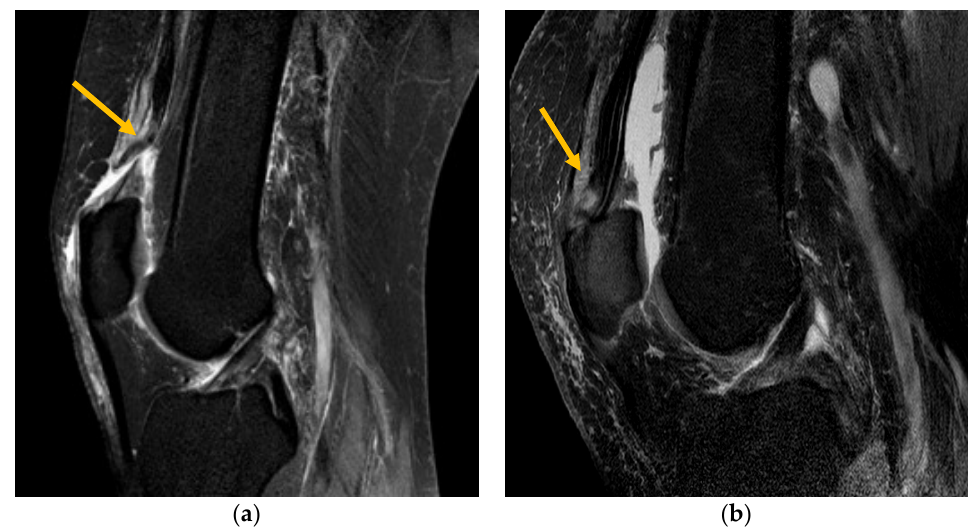
Figure 4. ( a ) T2-weighted sagittal MRI demonstrating complete QTR of the rectus femoris. ( b ) T2- weighted sagittal MRI demonstrating partial QTR of the rectus femoris subtendon.